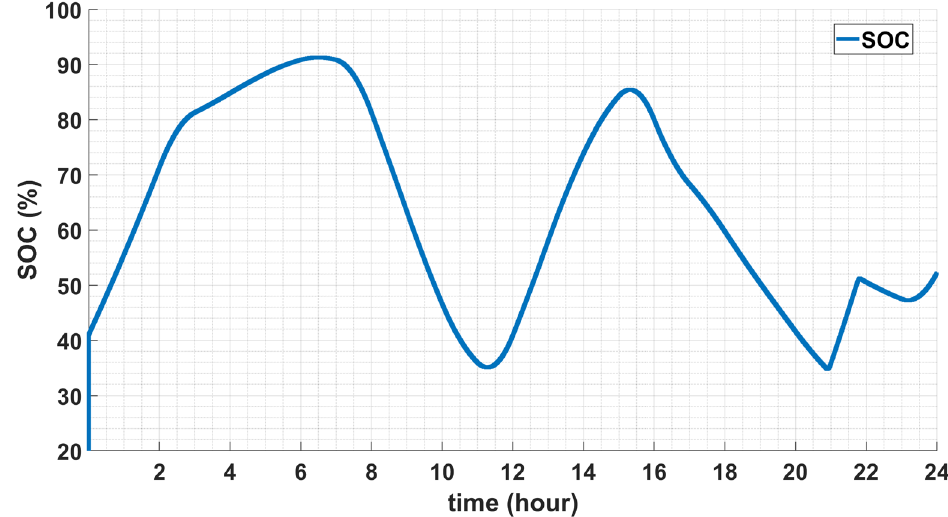
Figure 12. SOC of the ESS.